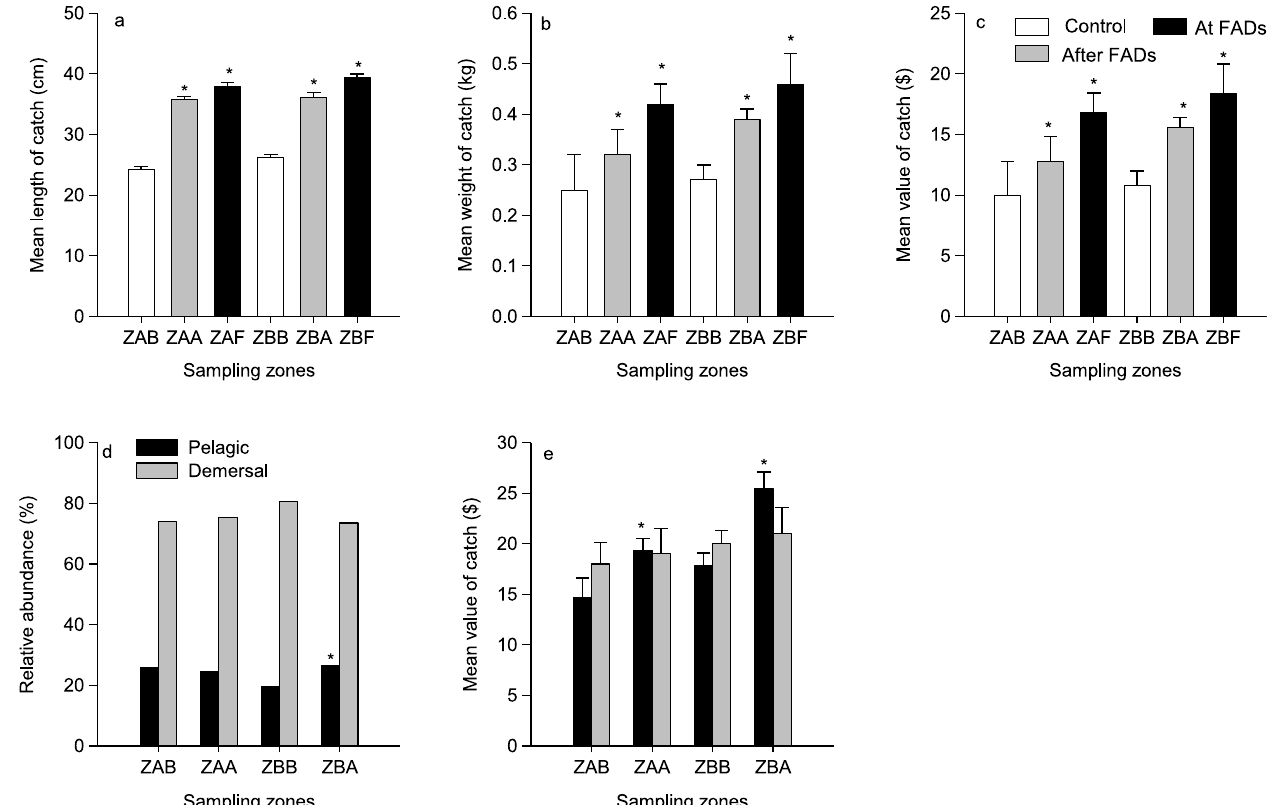
Fig. 2. The mean (SE) values of variables compared before and after deployment of AFADs in coastal Kenya. (a) length, (b) mass, (c) market value of catch per fi sher, (d) Relative abundance of pelagics and demersals, (e) market value of catch per fi sher for pelagics and demersals, Signi fi cant differences from controls are indicated; * p < 0.05. (ZAB (cid:2) Zone A Before FADs; ZAA (cid:2) Zone A After FADs; ZAF (cid:2) Zone A At FADs; ZBB (cid:2) Zone B Before FADs; ZBA (cid:2) Zone B After FADs; ZBF (cid:2) Zone A At